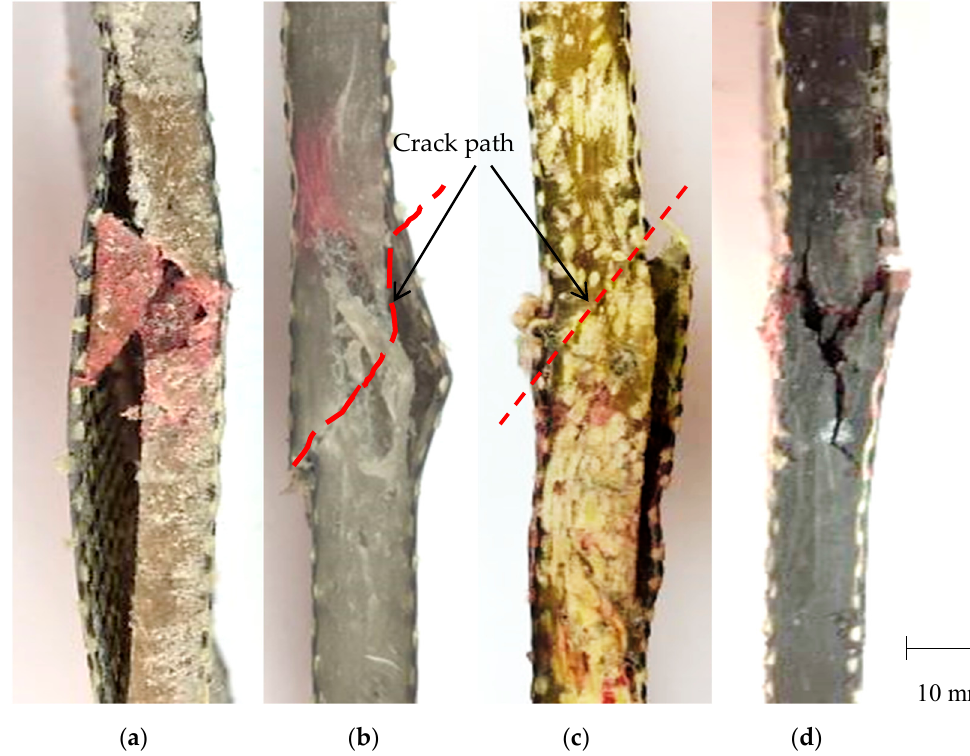
Figure 15. Cross-section of failure modes for the CAI testing of the ( a ) banana, ( b ) glass, ( c ) carbon, and ( d ) Kevlar epoxy sandwich structures.